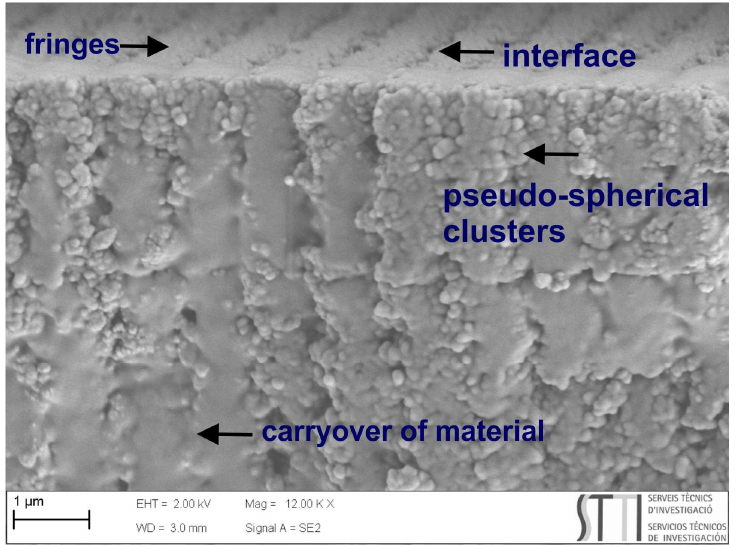
Figure 8. Enlargement of Figure 7 right showing aspects of the structure: interface between fringes, pseudo-spherical clusters that form the fringes, and areas with the carryover of